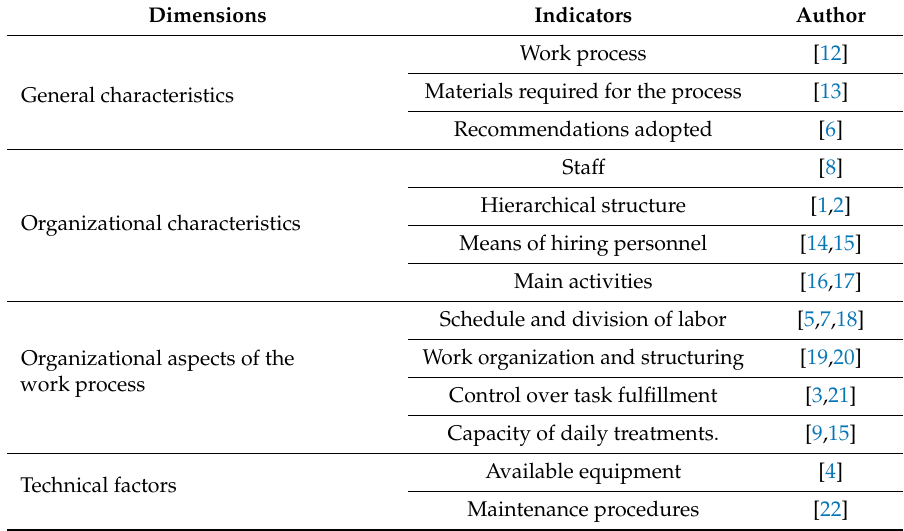
Table 1. Dimensions and indicators of